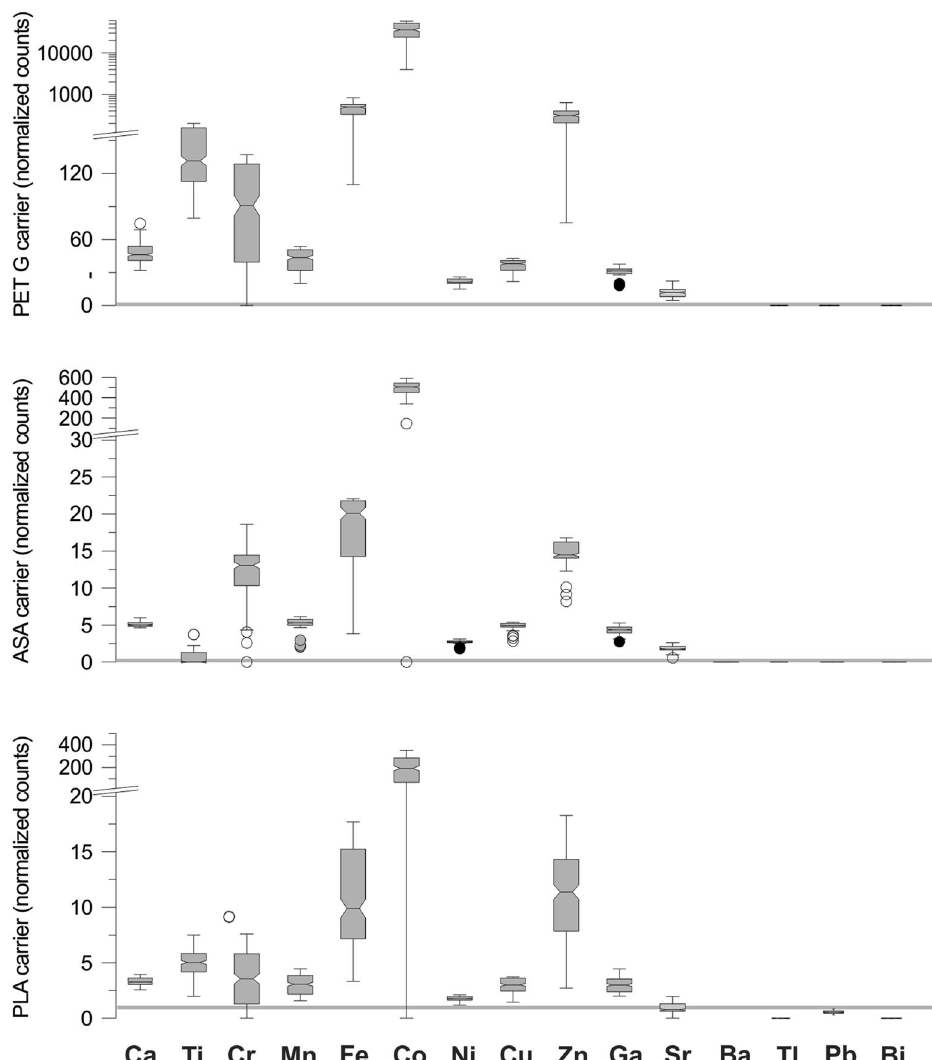
Figure 2. Comparison of sample-carrier-to-resin-blank element ratios for the different polymers used in this study. High ratios indicate that detectable levels of the element is present in the sample carrier materials. Noteworthy levels of Cr, Fe, Co, and Zn were observed in all three polymers used. Dotted gray line marks the 1:1 ratio, indicating no difference between sample carrier and resin